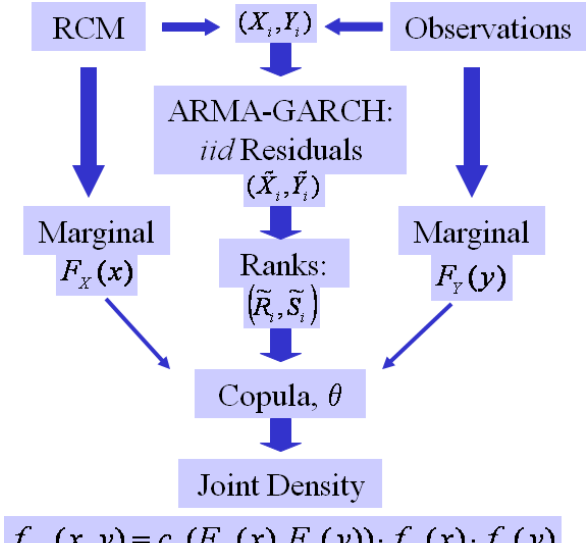
Fig. 3. Concept of the bias correction followed in this paper.